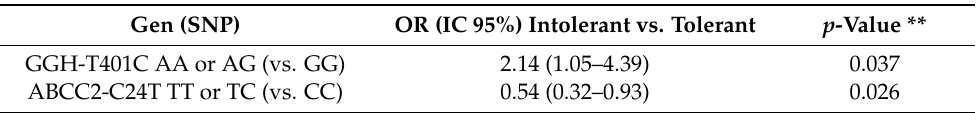
Table 4. Multivariate logistic regression to evaluate the association between MTX intolerance and genetic variants (final model). Gen (SNP) OR (IC 95%) Intolerant vs. Tolerant p -Value ** GGH-T401C AA or AG (vs. GG) 2.14 (1.05–4.39) 0.037 ABCC2-C24T TT or TC (vs. CC) 0.54 (0.32–0.93)